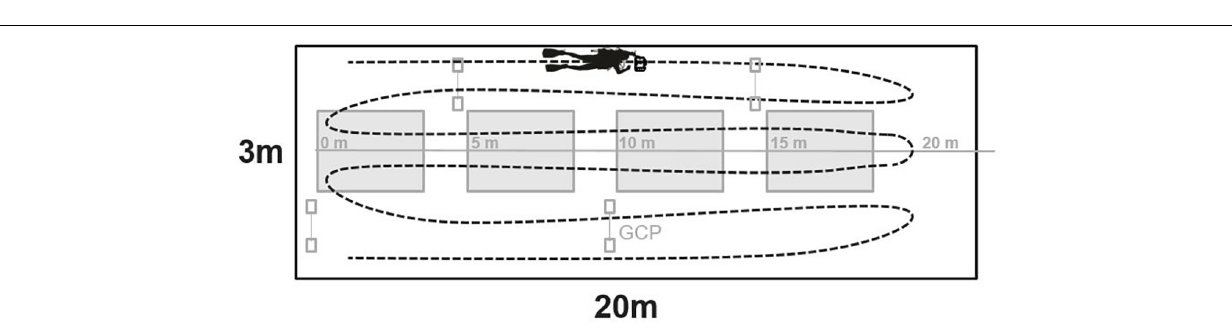
FIGURE 2 | Graphic of benthic survey plot with in-water visual survey segments (in gray). The SfM swim path is indicated by the black dashed line, covering an image area of 3 m × 20 m area. Note, at depths > 18 m, divers reduced the image survey area to 3 × 13 m. GCP, ground control